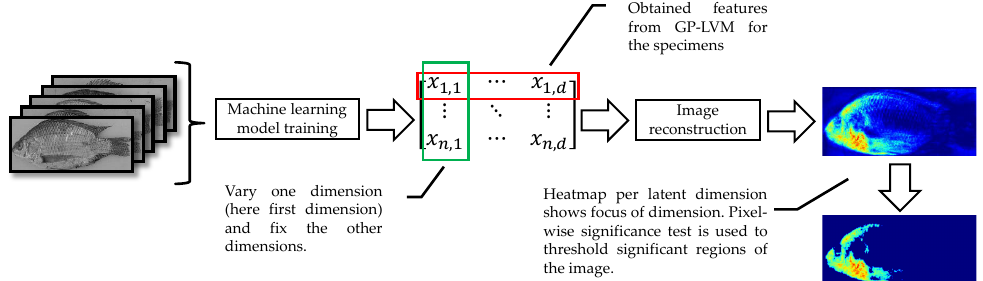
Figure 5. The procedure to visualize the latent dimensions. The image databases were used to obtain a latent space. For each dimension in the latent space, a heatmap was generated showing the variability generated by this dimension’s